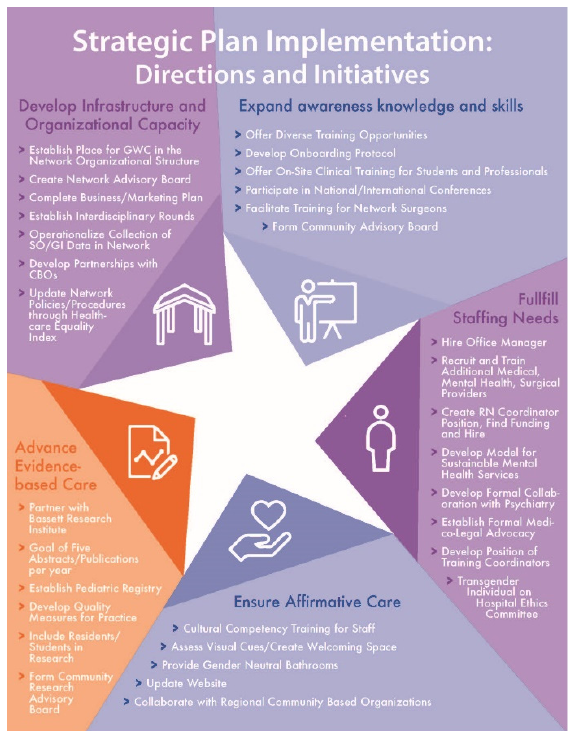
Figure 1. The five COE implementation focus areas and strategic plans for each. Figure originally published in “Leading Community Based Changes in the Culture of Health in the US: Experiences in Developing the Team and Impacting the Community (9)”.